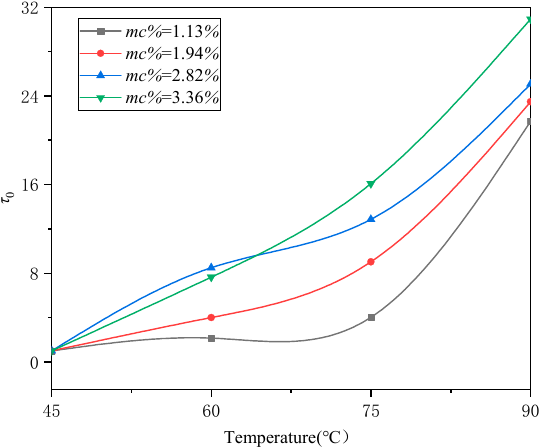
Figure 5. Normalized parameters ( τ 0 ) of cellulose pressboards with various moisture content.